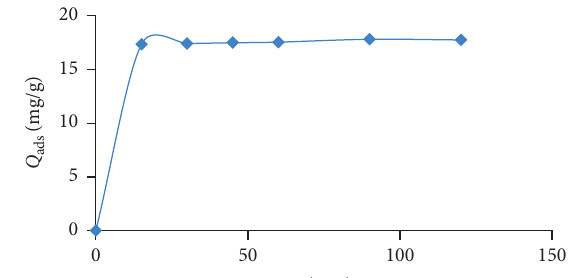
Figure 7: Influence of contact time on the adsorption of phenol on Sale